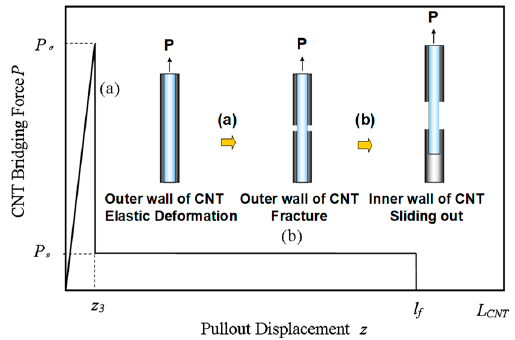
Figure 5. Typical bridging law and schematic diagram for sword-in-sheath mechanisms.